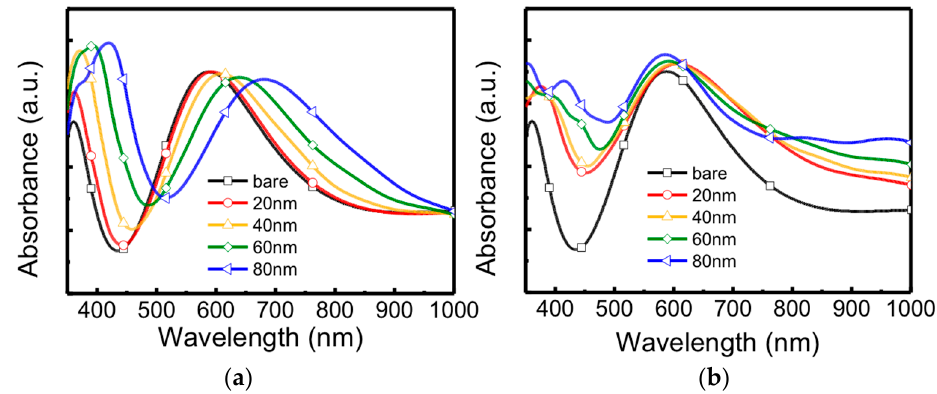
Figure 3. Simulated absorbance spectra of bare graphene and graphene with different size of Ag nanoparticles on ( a ) flat and few-layer graphene/SiO 2 /Si and ( b ) rough and multi-layer graphene/SiO 2 /Si.